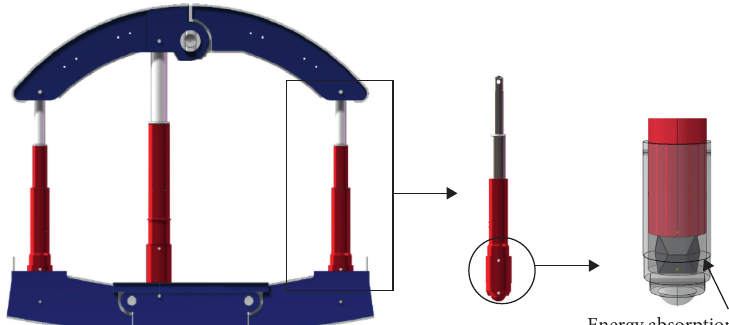
Figure 1: Location of the energy absorbing device.